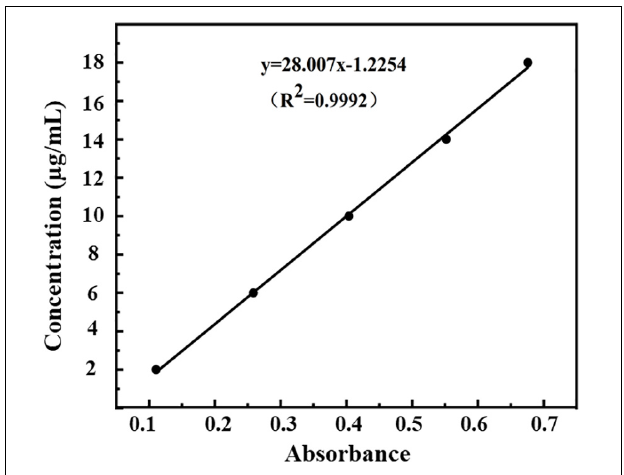
FIGURE 3 | Standard curve of absorbance-concentration of DHA measured at 238 nm by UV-VIS